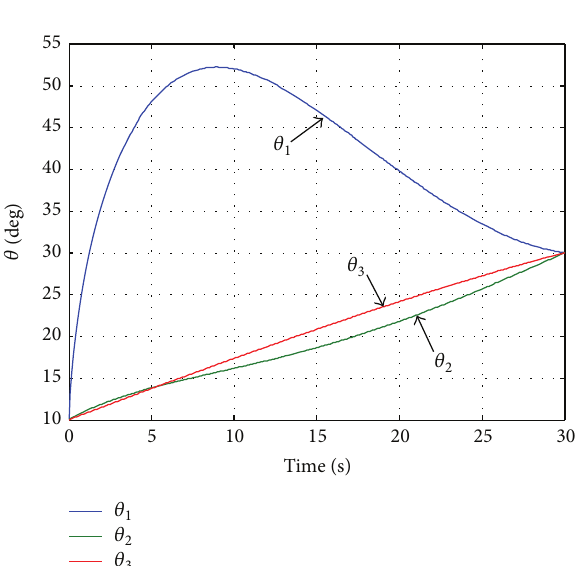
Figure 12: ‖𝐽 𝑅 ‖ 𝐹 versus 𝑡 × 𝑏 0 .